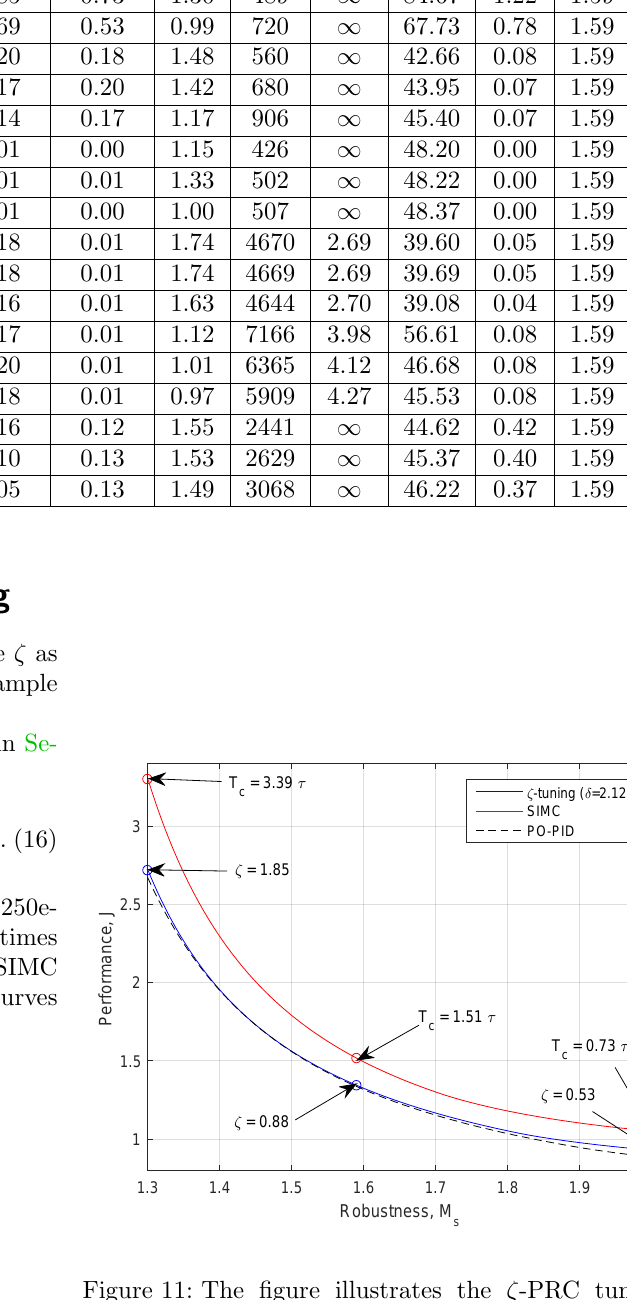
Figure 11: The figure illustrates the ζ -PRC tuning. Pareto performance J (Eq. (7)) vs. robust- ness M s trade-off